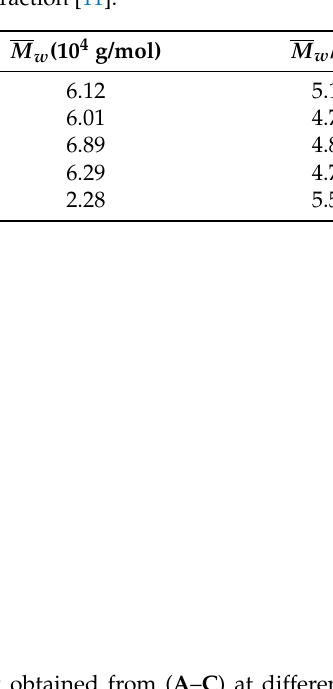
Table 1. Molecular weight and its distribution of sol fraction [11].